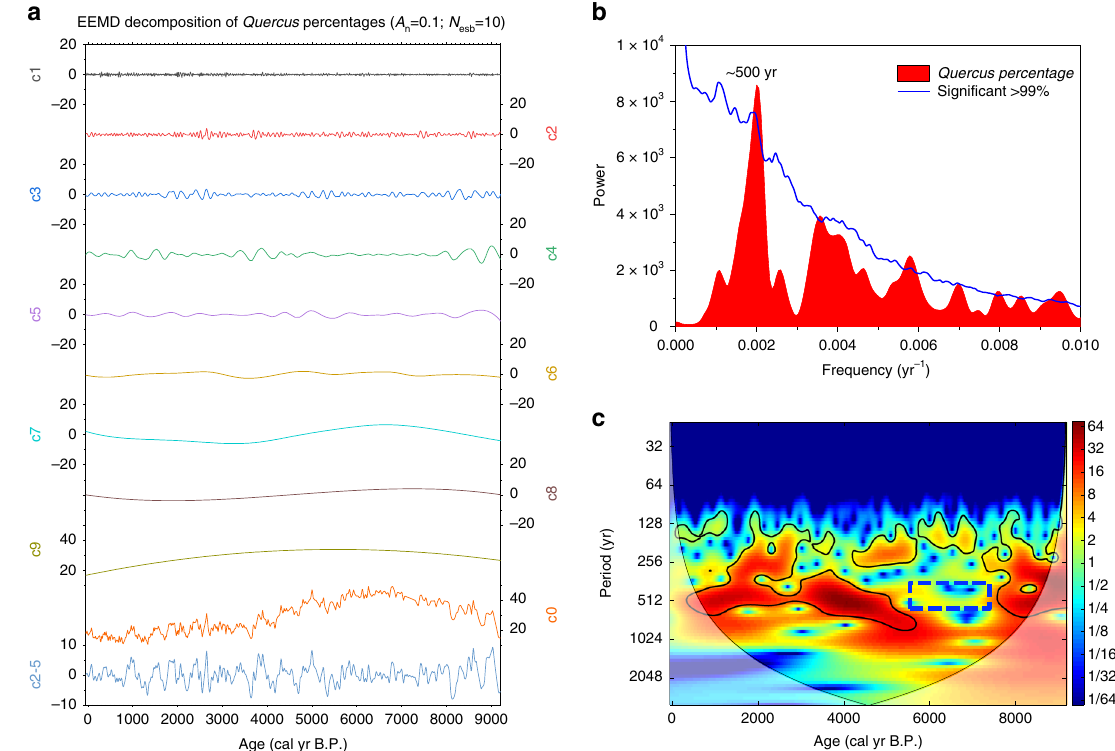
Fig. 3 Results of time-series analysis of the Quercus percentages for NE China. a EEMD 35,36 : white noise ( A n ) of 0.1 and the component number ( N esb ) of (cid:1) (cid:3) þ 1 10 (cid:1) Log 922 are used for the fi rst EEMD component. Component c0 represents the original Quercus percentages. To remove high-frequency 2 fl uctuations and orbital and millennial trends, a new detrended time series (c2-5) was generated by summing components c2-c5 from the fi rst decomposition (c0). b Results of univariate spectral analysis 37 of the Quercus percentages time-series over the past 9260 yr. c Wavelet power spectrum 38 of Quercus percentages. The 95% con fi dence level is outlined in black. The blue dotted box indicates weak oscillations of ~500-yr cyclicity during the period of ~7500 to 5700 cal yr